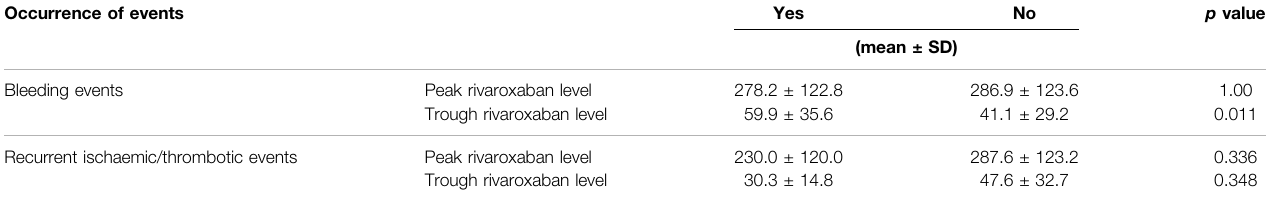
TABLE 4 | Mean peak and trough plasma rivaroxaban level in patients with or without bleeding events and recurrent ischaemic/thromboembolic events. Occurrence of